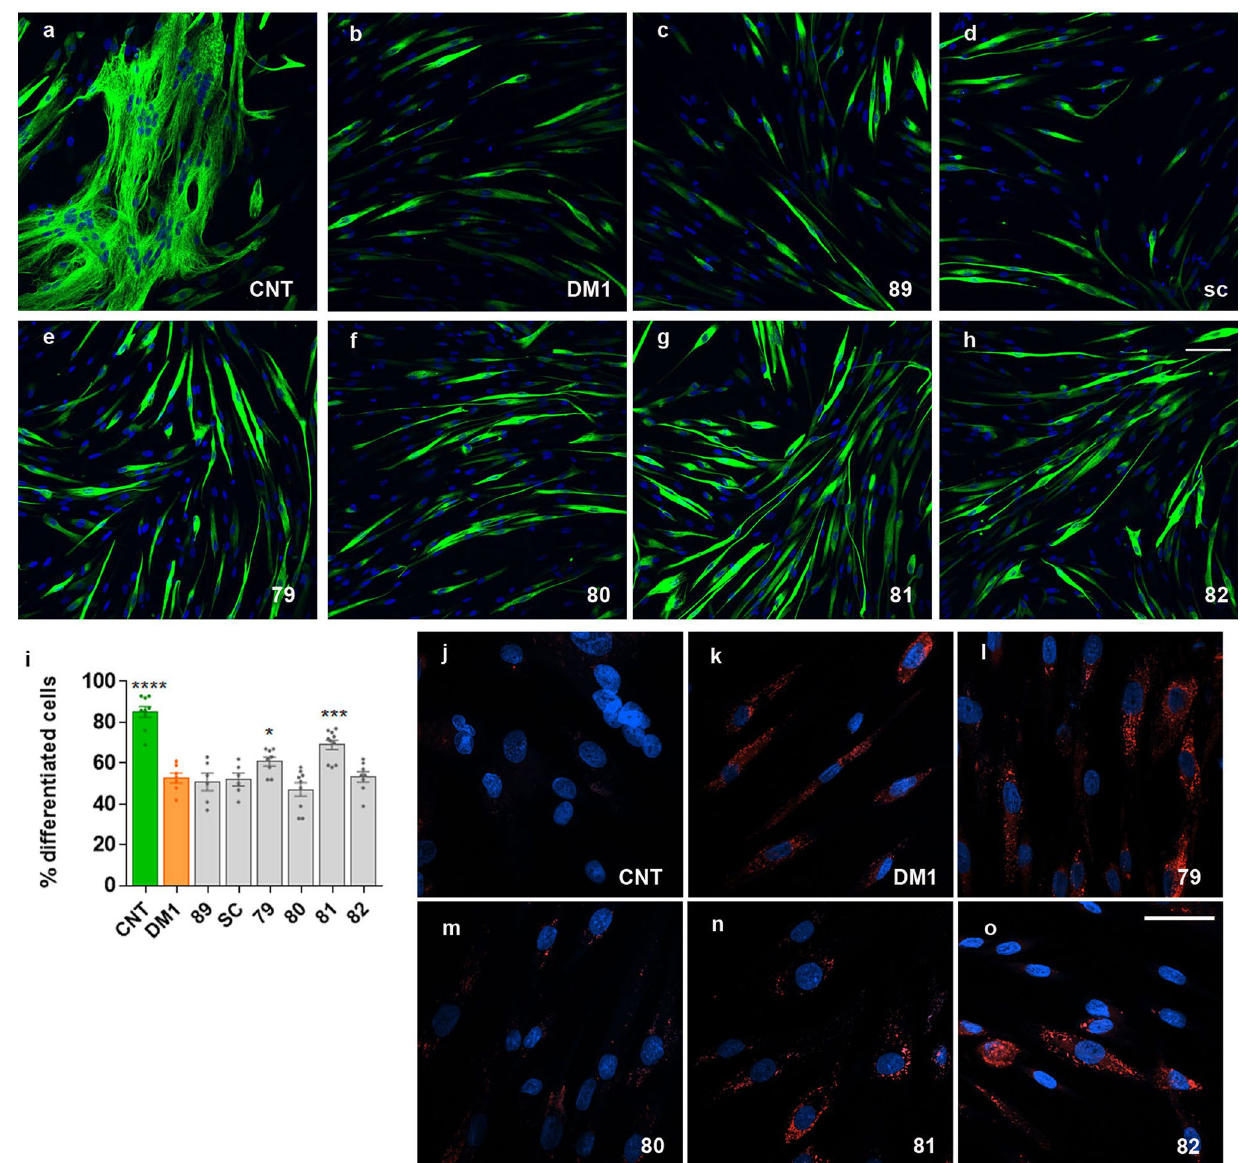
Figure 4. Differentiation delay and autophagy hyperactivation were rescued by peptides. Representative micrographs of control (CNT, a ; without DMSO), DM1 (DMSO 0.1%; b ) and DM1 cells treated with negative control ( c , d ) or candidate peptides ( e – h ) stained for Desmin (green signal) as a marker of myogenic differentiation. Cells differentiated in DMEM for seven days and were treated with 10 µM of the indicated peptides. Quantification of the number of Desmin-positive cells relative to the total number of cells ( i ) revealed a significant increase in myogenic cells when treated with peptides 79 and 81 (counting over 250 nuclei from randomly chosen Desmin-positive cells from 5–7 micrographs). Human myotubes stained with LysoTracker (red fluorescence; j – o ). Autolysosomal labeling is observed in DM1 myotubes (DM1) but not in controls (CNT), denoting increased autophagy in DM1 cells. Cells treated with peptide 80 showed a general reduction of the signal from auto lysosomal vesicles while for cells treated with peptides 81 and 82, an increase in the number of cells without autophagic vesicles around the nucleus was observed. ( a – h , j – o ) Nuclei were counterstained with Hoechst 33258 (blue). Three independent experiments were carried out. *p < 0.05, **p < 0.01, ***p < 0.001 according to Student’s t-test. Scale bar corresponds to 100 ( a – h ) and 40 microns ( j – o ability achieved by flies treated with the peptides was significantly higher than values obtained for control flies (p < 0.0008 in all cases). No significant differences were observed when comparing flies treated with control peptides and control flies. In flight tests, while there were no significant increases in the height of the landing distance (indicative of better flight capabilities), we found an increase in the percentage of flies capable of flying, especially in the case of peptide 82 treatment, where it reached statistical significance and almost doubled the value observed in control-treated DM1 flies (p = 0.0044, Fisher’s exact test; Fig. 5k). In conclusion, the increase in